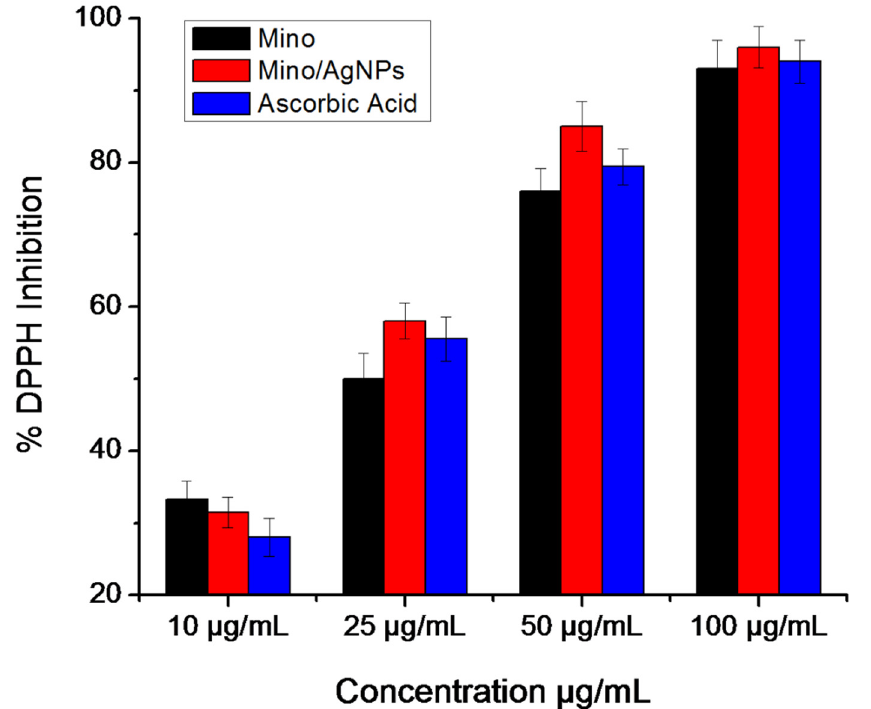
Figure 6. DPPH free radical scavenging assay.